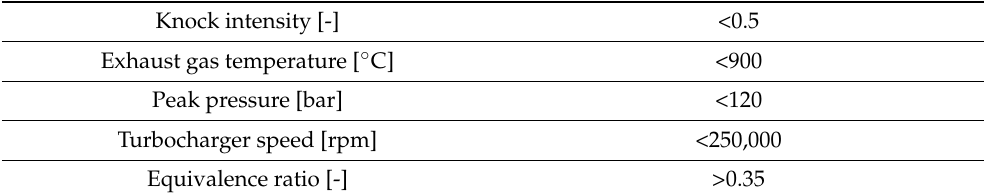
Table 3. Analysis